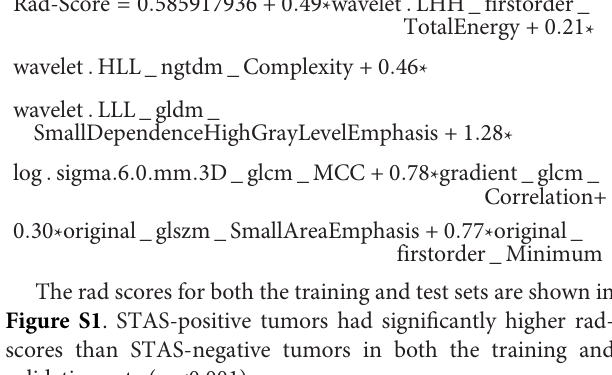
Figure S1 . STAS-positive tumors had signi fi cantly higher rad- scores than STAS-negative tumors in both the training and validation sets (p <0.001).